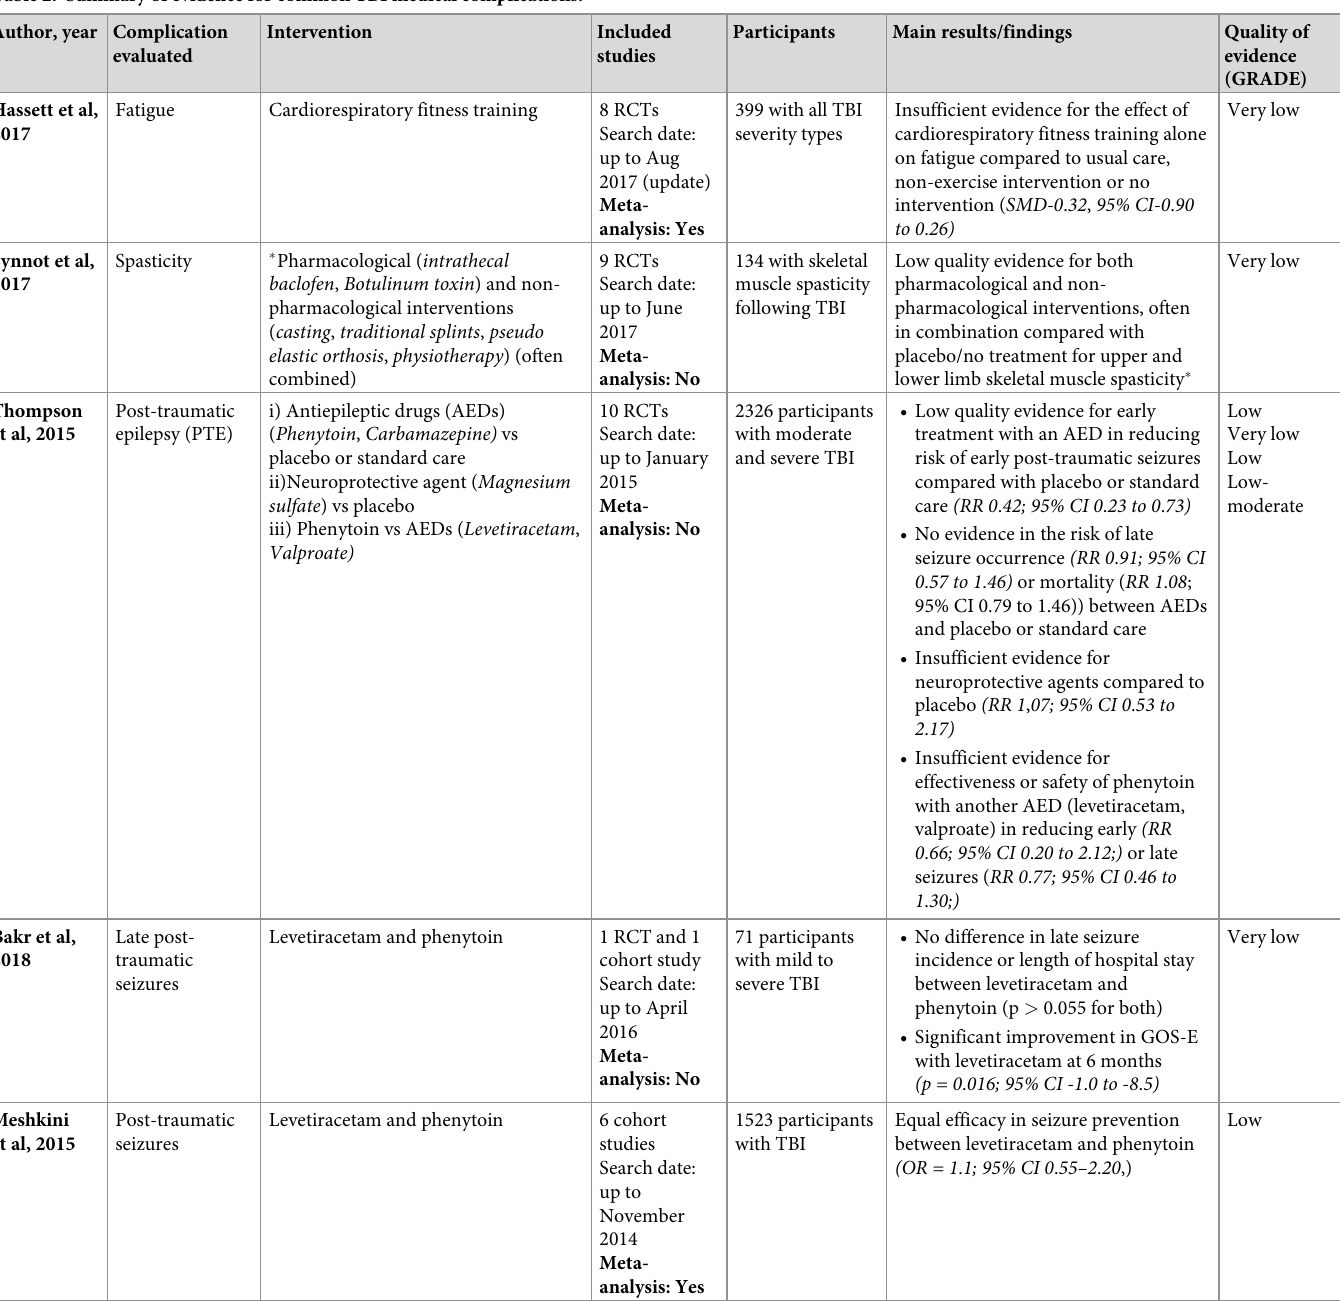
Table 2. Summary of evidence for common TBI medical